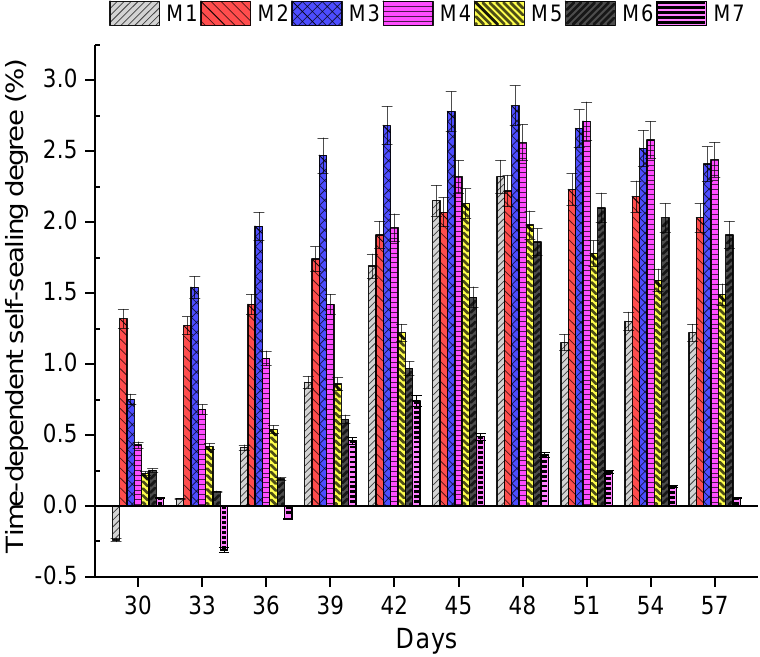
Figure 11. Time-dependent self-sealing degree.